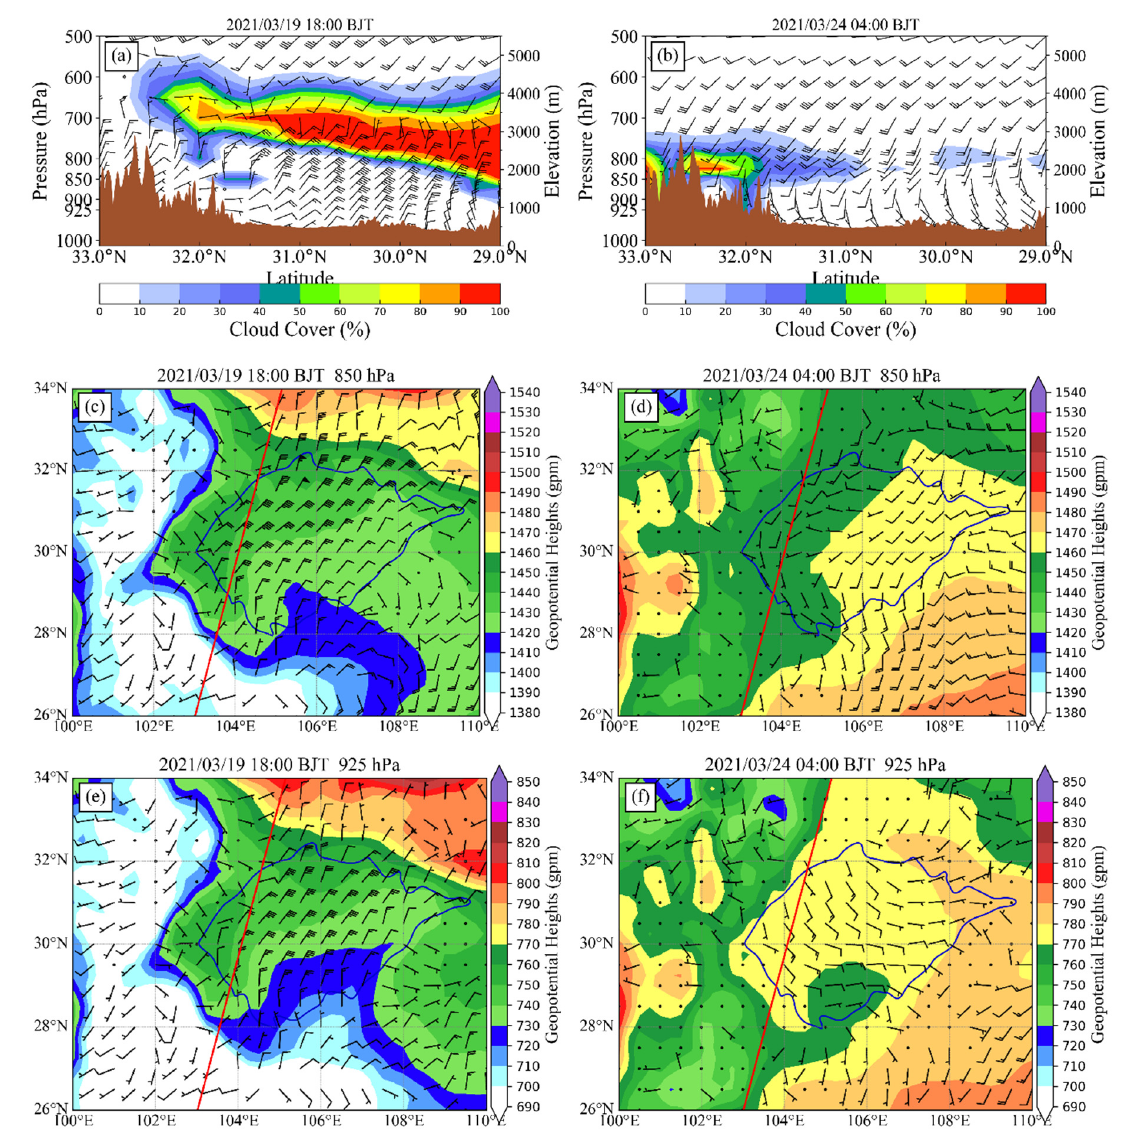
Figure 4. The cross-section of cloud fractions along the red line ( a ), the geopotential heights and horizontal wind fields at 850 hPa ( c ), and 925 hPa ( e ) at 18 p.m. BJT on 19 March 2021 from ERA5 reanalysis data. Panels ( b , d ) and ( f ) present the same contents as ( a , c ) and ( e ), respectively, but at